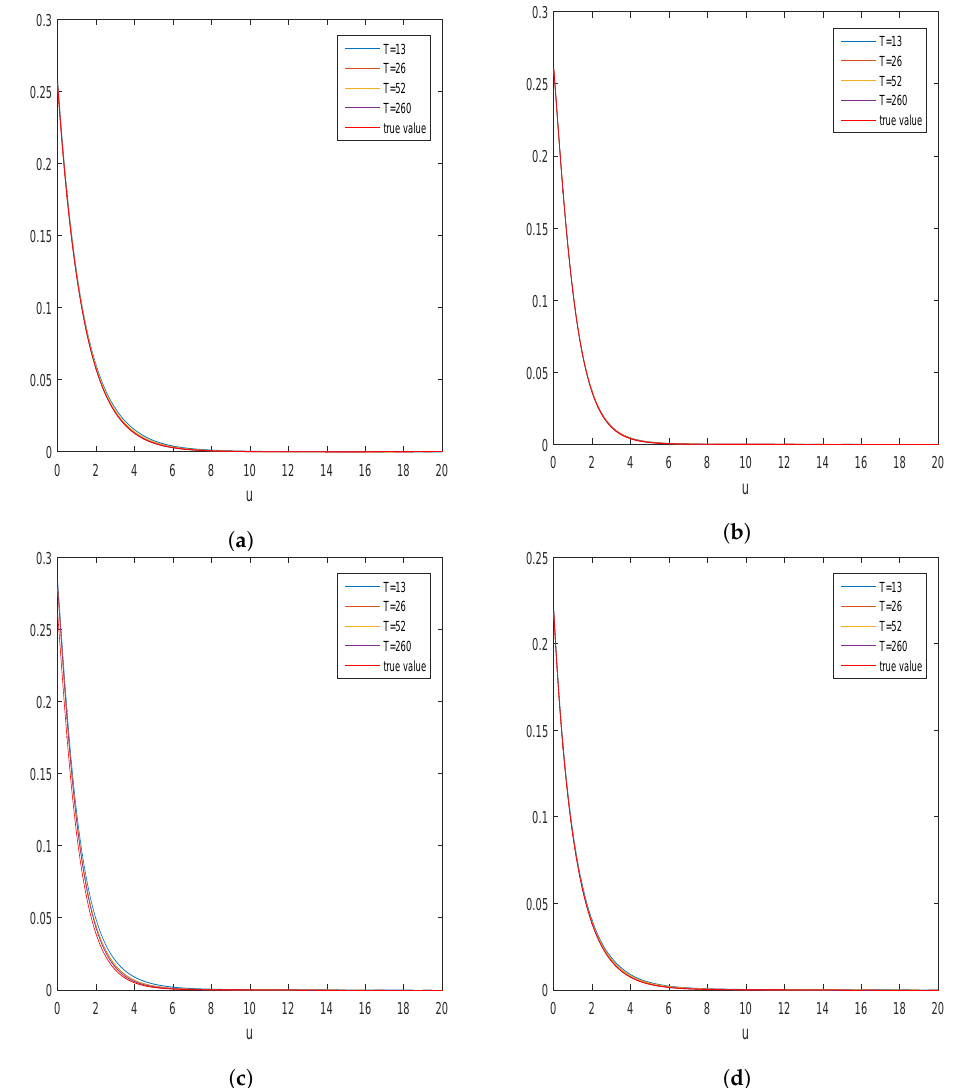
Figure 1. Estimation of the ruin probability for different claim sizes. Mean curves: ( a ) exponential claim sizes; ( b ) Erlang claim sizes; ( c ) combined-exponential claim sizes; and ( d ) mixed-exponential claim